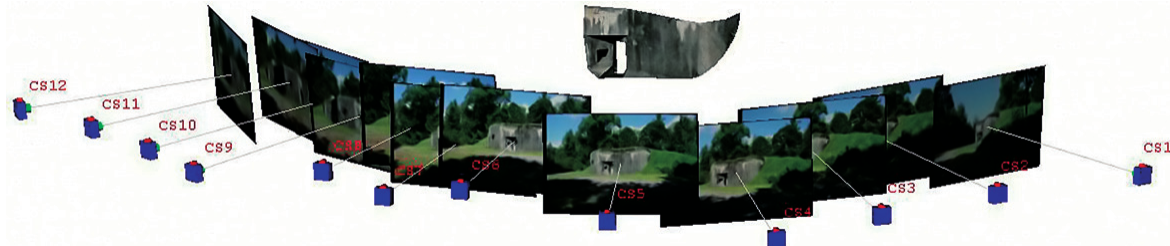
Fig. 3. MO-S 18 with camera positions for convergent imaging